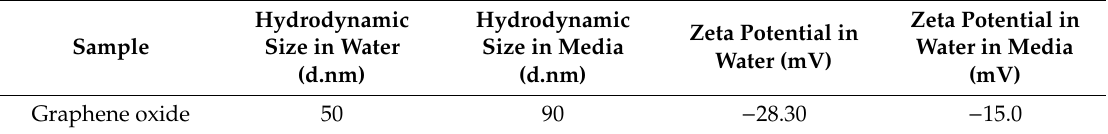
Table 1. Dynamic light scattering analysis and zeta potential measurement of graphene oxide in water and culture media.